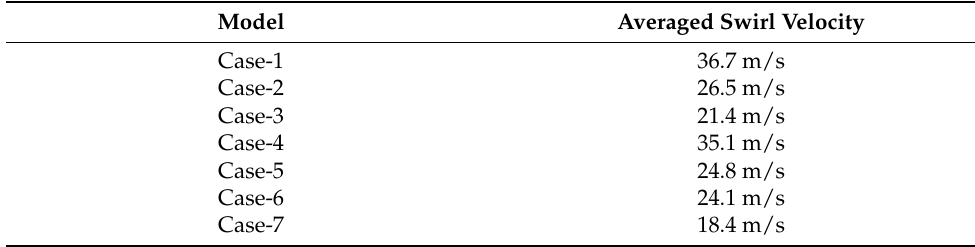
Table 2. Averaged swirl velocity on the plane 0.2 mm upstream of the bristle pack.